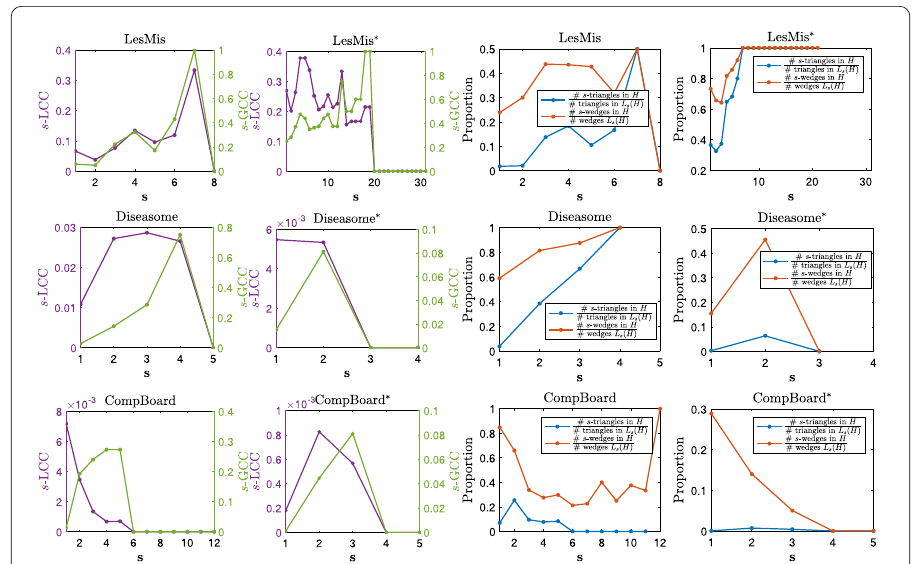
Figure 8 Mean local and global s -clustering coefficients (left), and proportion of triangles and wedges in the s -line graph that correspond to s -triangles and s -wedges (right) for LesMis, Diseasome, and CompBoard, and their dual hypergraphs